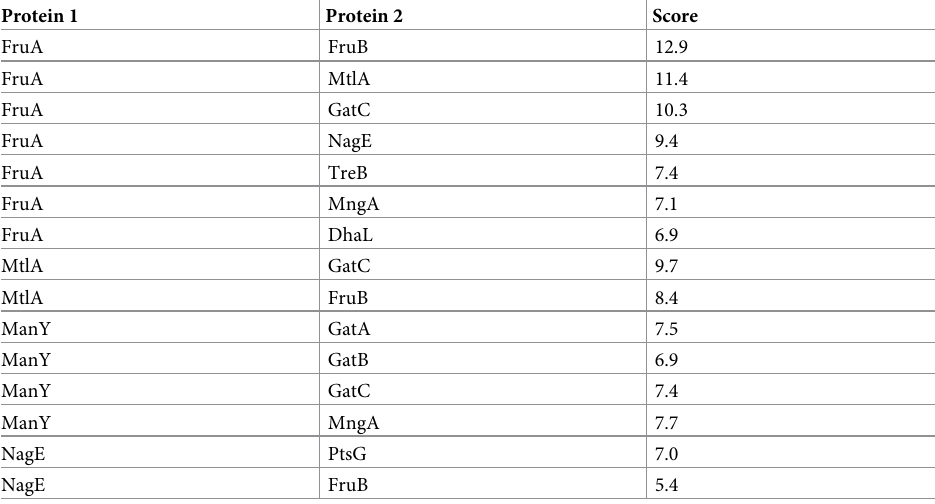
Table 2. Selected high scoring PTS transporter (Enzyme II complex) interactions. The data were derived from Babu et al., 2018 [1]. The higher the score, the stronger the interaction should be, although these scores are also depen- dent on the protein